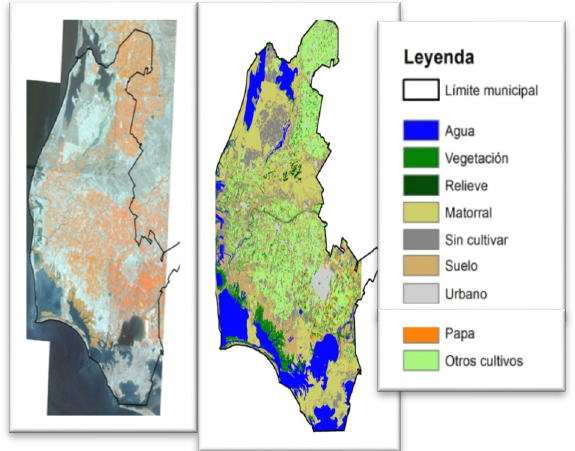
Figure 3. Results obtained for potato